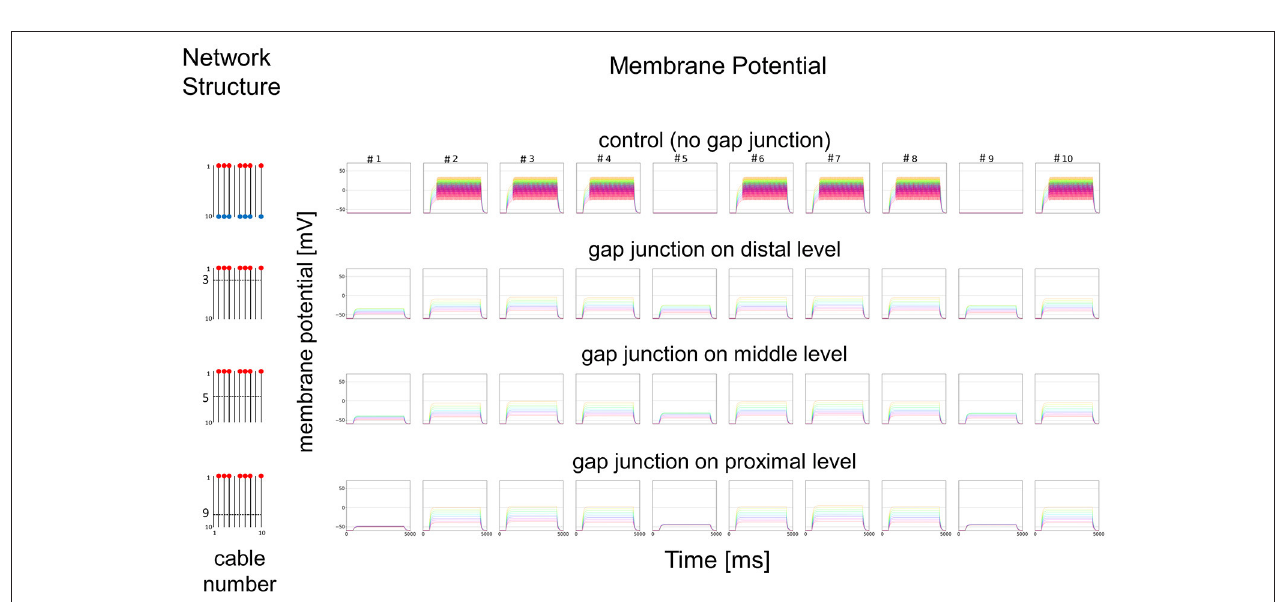
FIGURE 8 | Simplified model and functional simulation with a weak stimulation. Simulation results for the small amplitude of input current in the same model as Figure 7 .